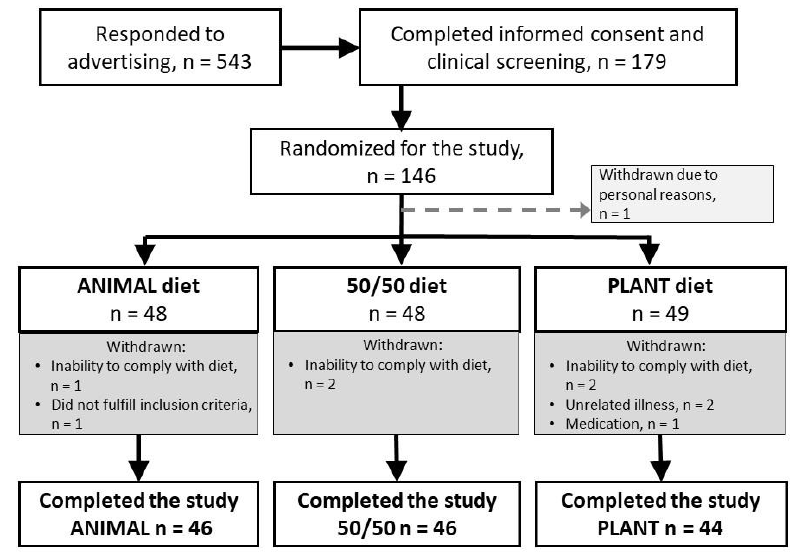
Figure 1. Flow chart of the participants. Dropouts are shown on grey background.